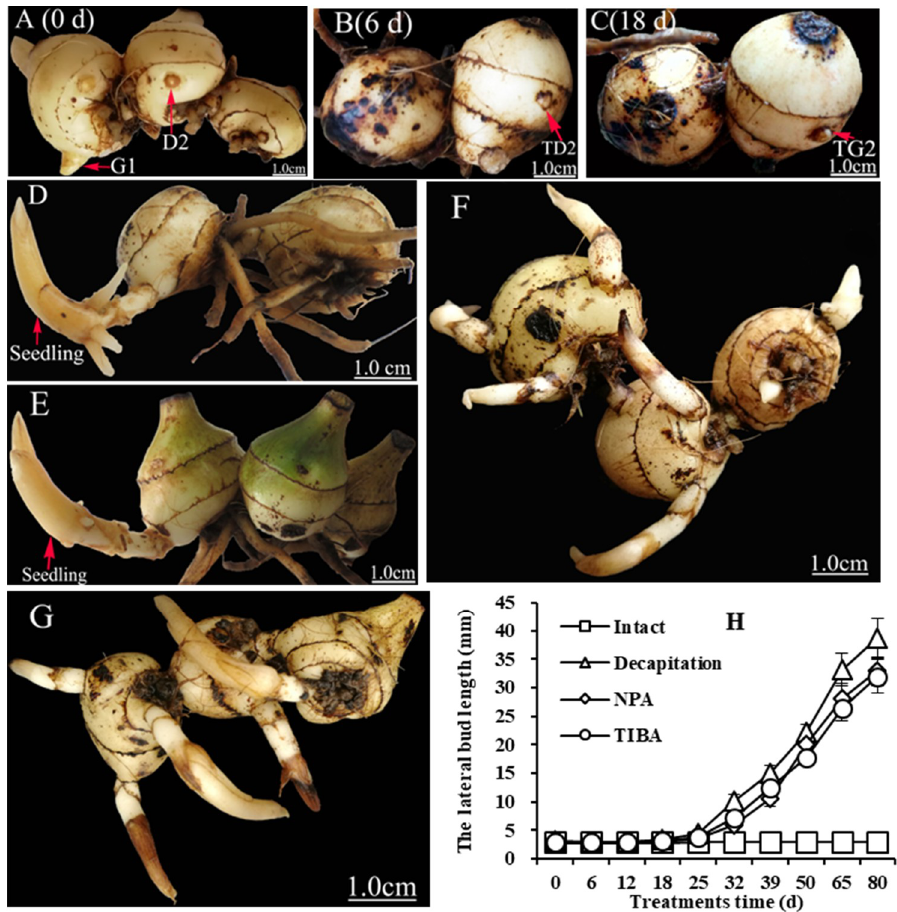
Figure 2. The decapitation, NPA, and TIBA treatments promoted lateral bud outgrowth: ( A – C ) morphological pictures of the lateral buds at three representative time points (0, 6, and 18 days post-decapitation); ( D – G ) morphological pictures of decapitated and intact plants, and those treated with NPA and TIBA after for 80 days; and ( H ) the statistical chart of bud length. Values are means ± SDs, n = 3. Error bars indicate standard deviations obtained from three biological replicates.